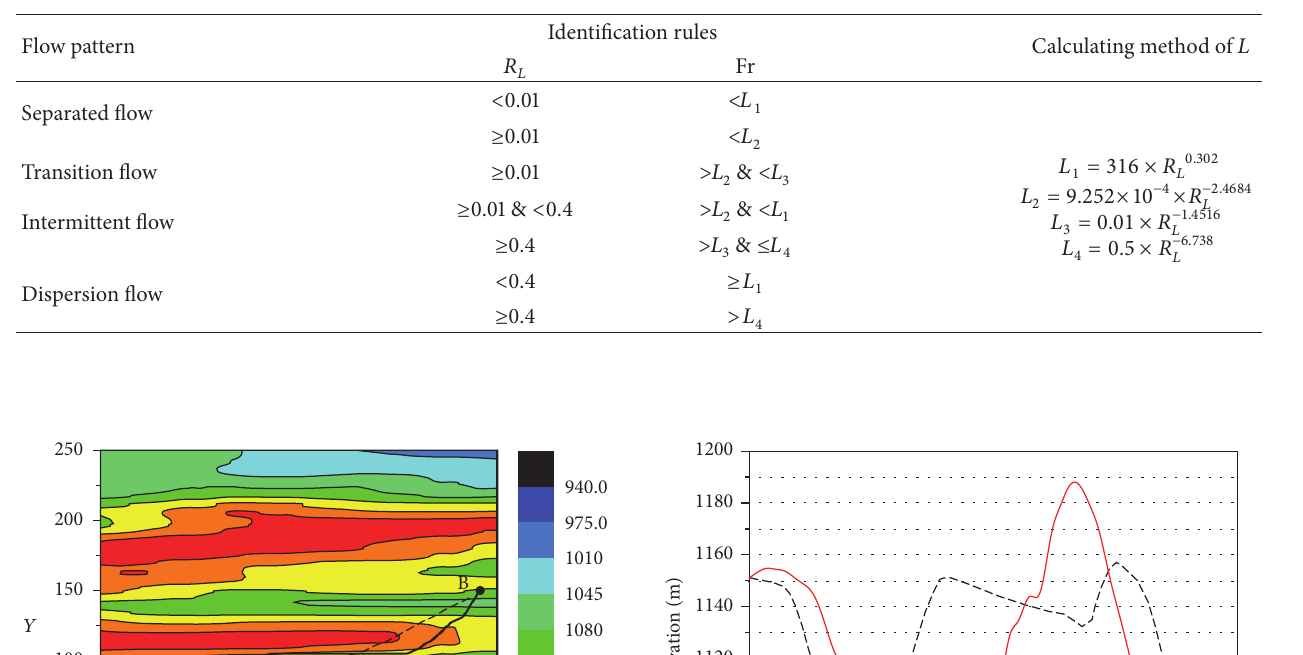
Table 5: Rules of flow pattern identification.